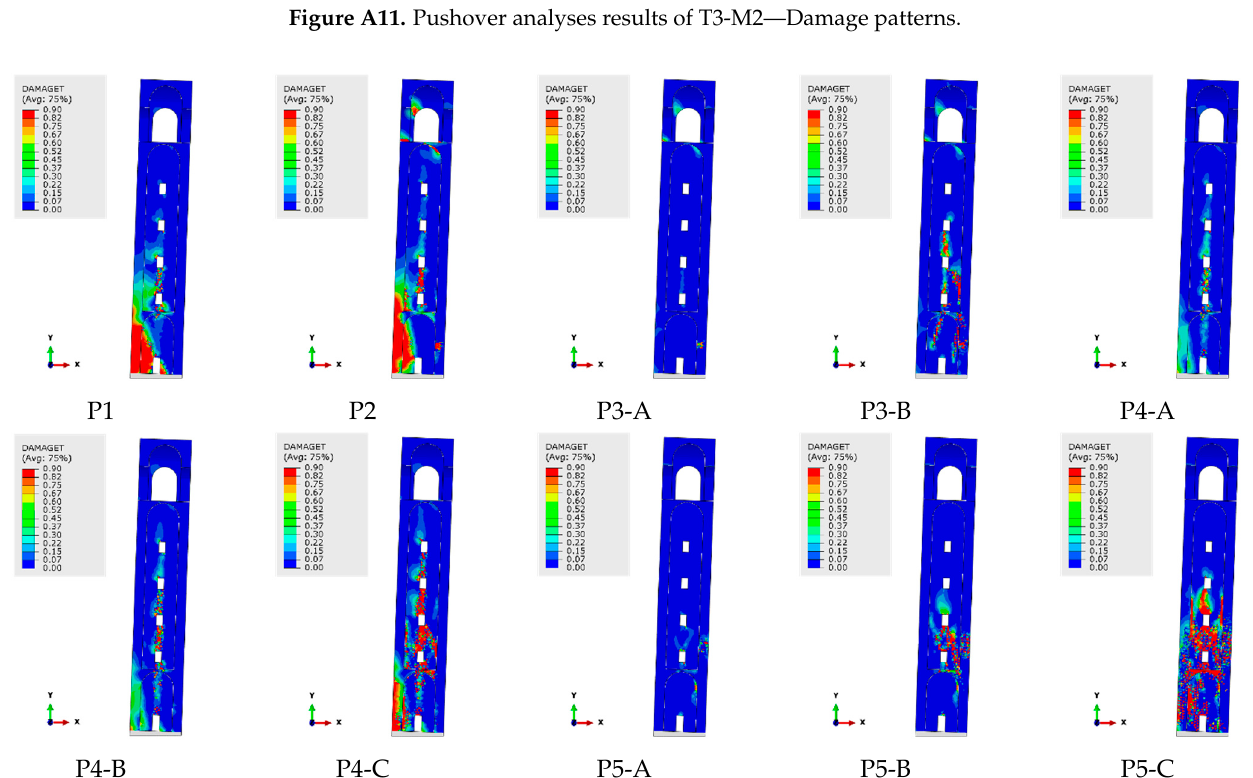
Figure B8. Pushover analyses results of T3-M2—Damage patterns.